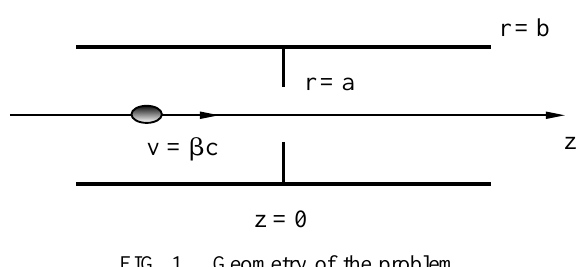
FIG. 1. Geometry of the